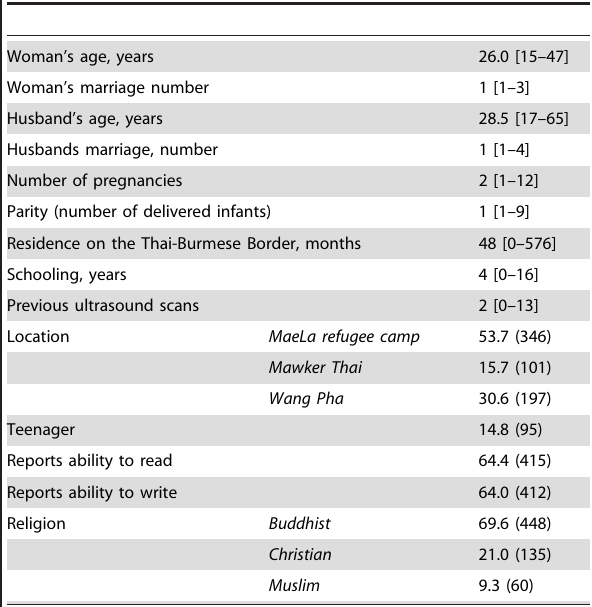
Table 1. Demographics of 644 women participating in the